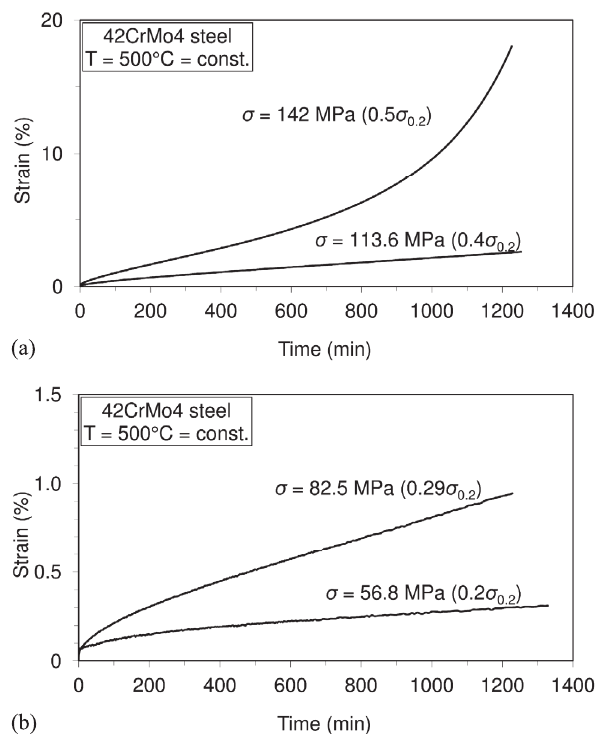
Fig. 5: Short-time creep tests of 42CrMo4 steel at temperature of 500 °C (773 K). (a) Stress levels: 0.4 s 0.2 and 0.5 s 0.2 . (b) Stress levels: 0.2 s 0.2 and 0.29 s 0.2 .